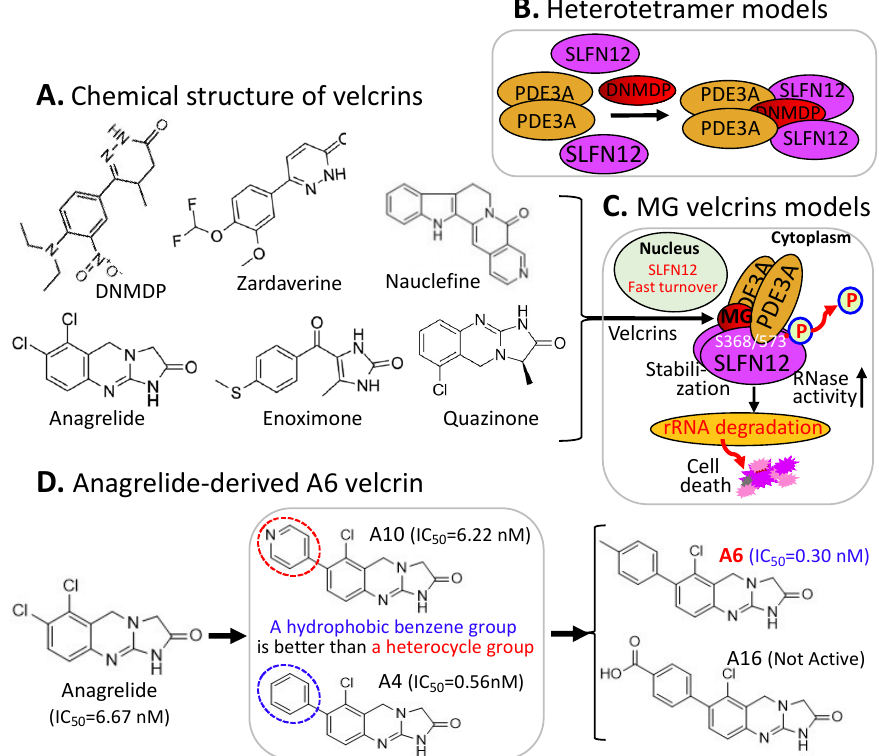
Figure 7. ( A ) Chemical structure of the velcrin-type of MG compounds; ( B ) DNMDP-mediated PDE3A–SLFN12 heterotetramer formation models; ( C ) a cartoon model for elucidating the velcrin compound-induced mechanism of action for inducing cell death; ( D ) summary of the structure– activity relationship (SAR) of representative anagrelide analogs for deriving the lead compound A6.